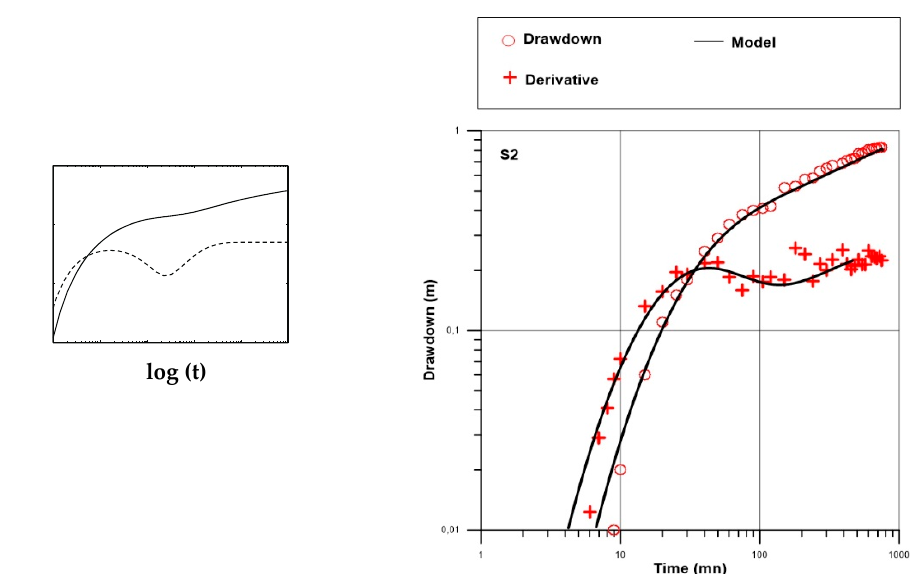
Figure 11. Interpretation of pumping test S1/S2: diagnostic plot ( left ) and data superimposed with a fitted Double porosity model ( right ).